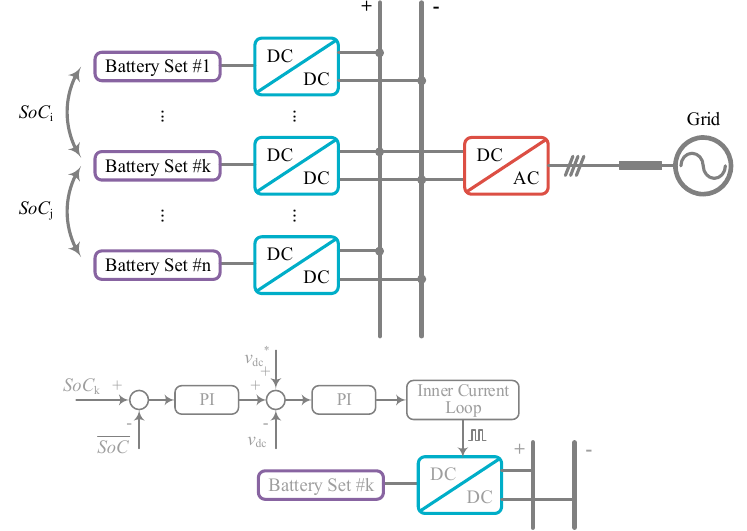
Figure 2. Control diagram of Stage I: average-based state-of-charge (SoC) balancing and conventional DC voltage and current control loops.